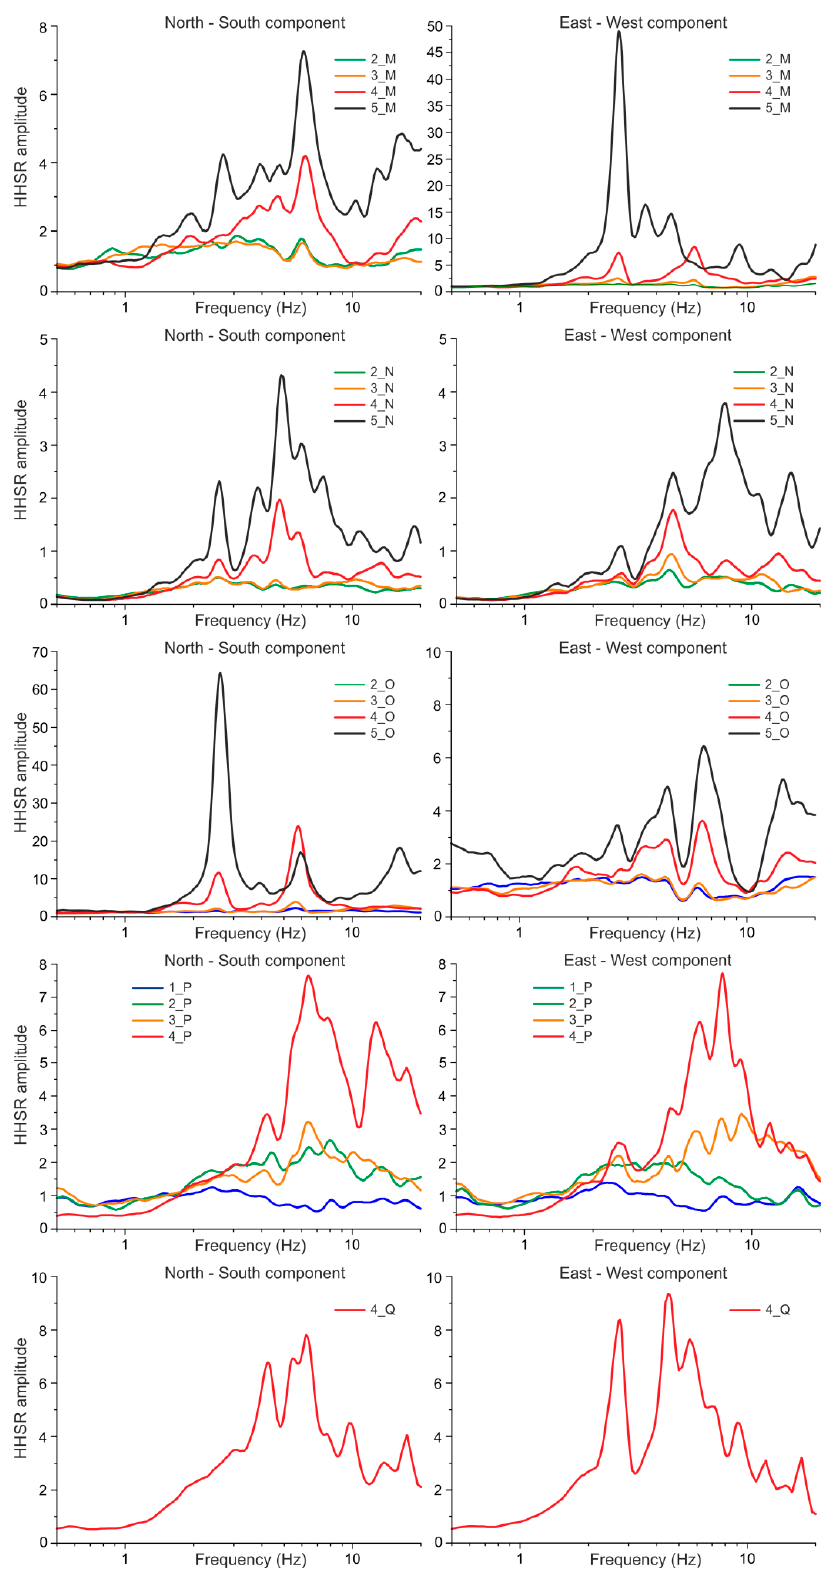
Figure 6. HHSR plots obtained from noise recordings performed at floors one (basement) to five (roof) for the sites M, N, O, P, and Q.